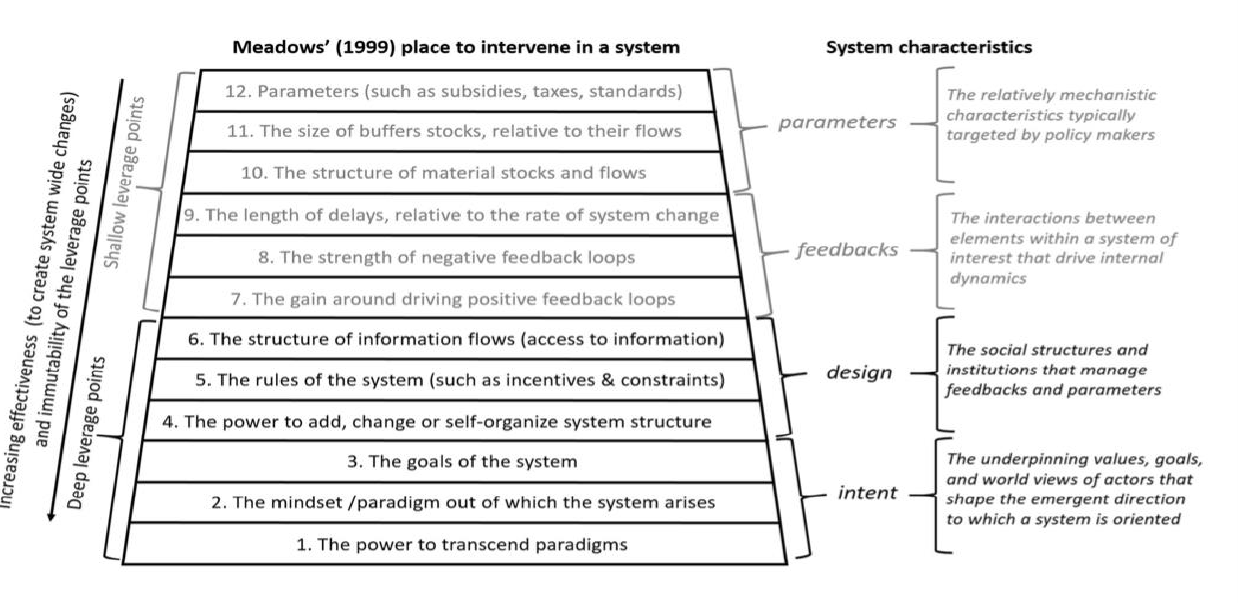
Figure 1. Displaying Leverage Points and System Characteristics [9] (p. 32).